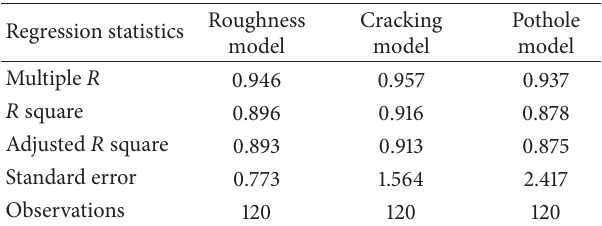
Table 4: Regression statistics of the developed models.